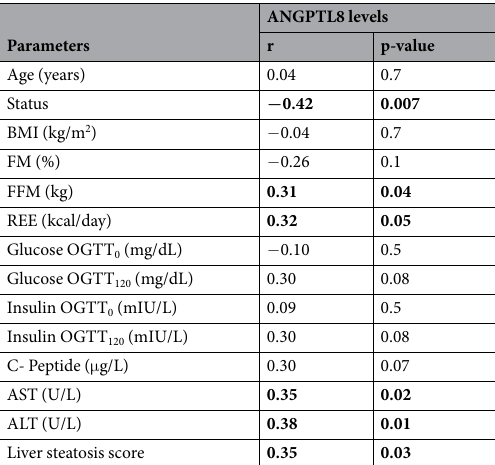
Table 3. Pearson’s correlation analysis between ANGPTL8 levels and anthropometric and biochemical parameters in the study populations as a whole. For obese status: PWS = 1, common obese = 0. Significance is shown in bold characters. BMI, body mass index; FM, fat mass; FFM, fat free mass; REE, resting energy expenditure; OGTT, Oral Glucose Tolerance Test; OGTT 0 and OGTT 120 , OGTT at time 0 min and 120 min;